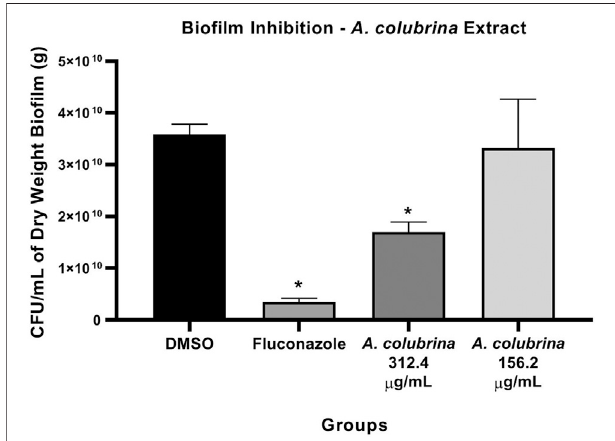
FIGURE 1 | Fungal viability of C. albicans MYA 2876 72-hours-bio fi lm expressed in CFU/ml/grams of dry weight after treatment with A. colubrina extract (312.5 μ g/ml – 20 × 15.62 μ g/ml; 156.2 μ g/ml – 10 × 15.62 μ g/ml). DMSO 0.1%: vehicle control; Fluconazole (10 μ g/ml): positive control. Values shown with asterisk (*) are statistically signi fi cant when compared to the vehicle control ( p < 0.05).